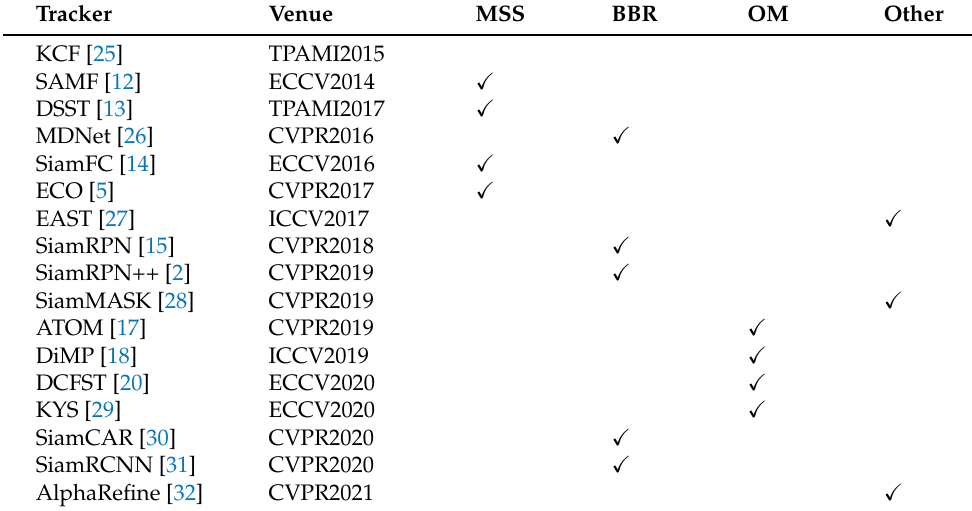
Table 2. Modern trackers and the used bounding box estimation methods.